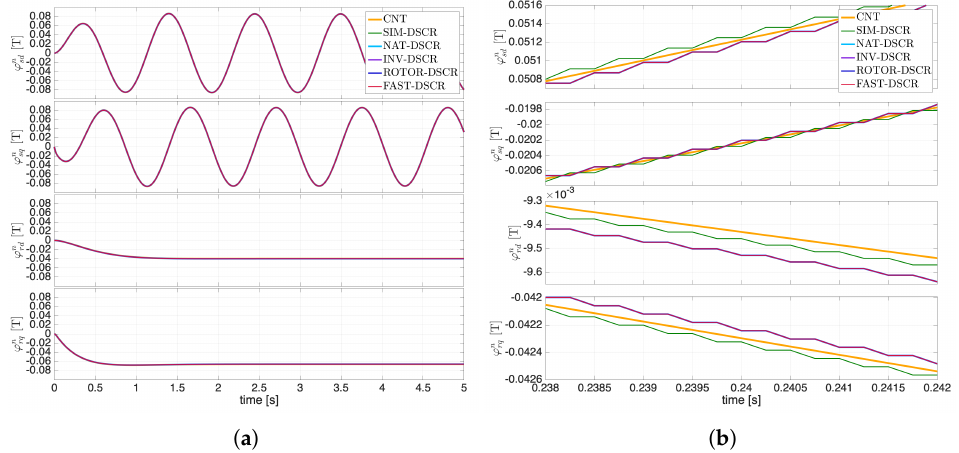
Figure 11. Simulink flux machine model comparison example between the model presented: CNT, SIMULINK-DSCR, NAT-DSCR, INV-DSCR, ROT-DSCR and FAST-DSCR. ( a ) overview, ( b ) zoom to highlight